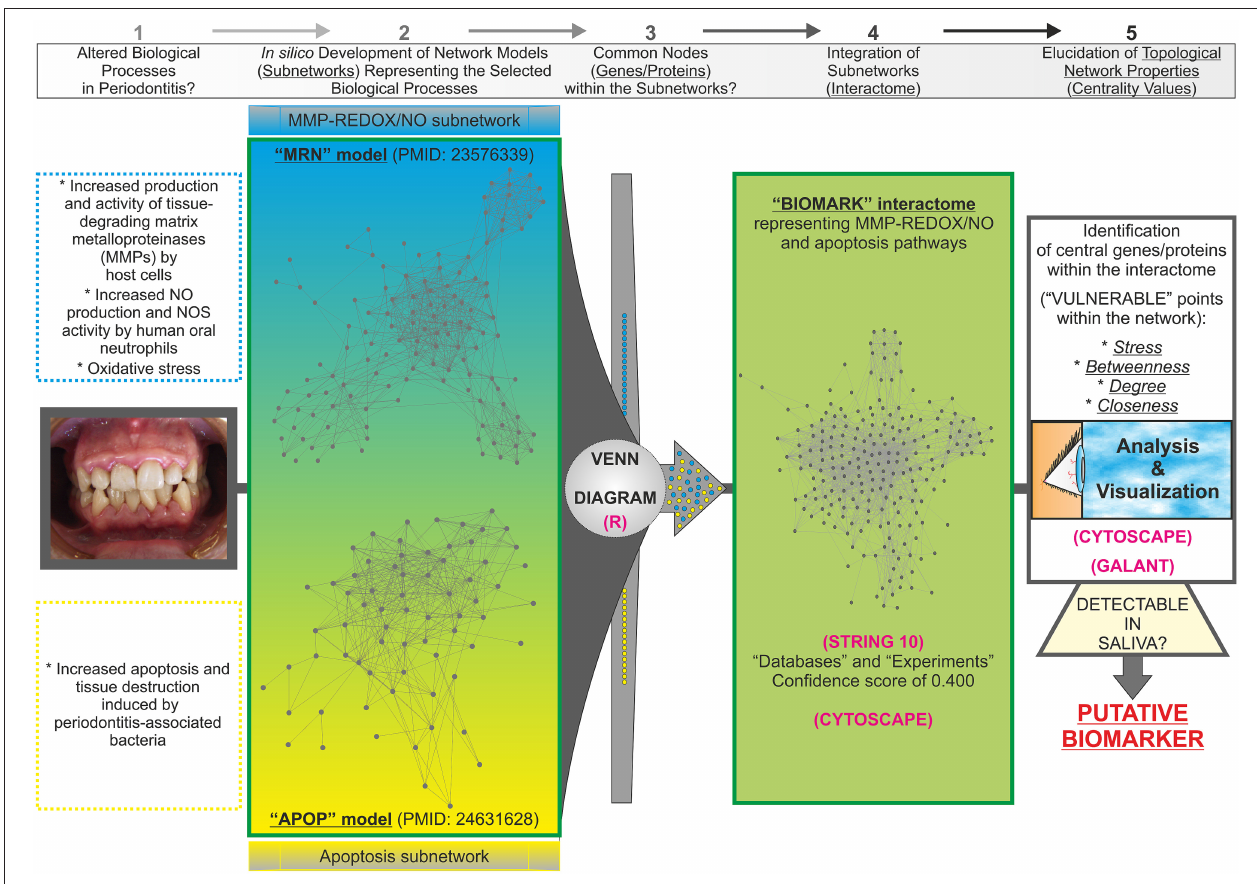
FIGURE 1 | Abstract workflow summarizing the criteria and tools used for the present study. The “MRN” and “APOP” in silico models, already available in the literature, were used as the starting material to develop the “BIOMARK” integrating MMP-REDOX/NO and apoptosis related-genes/proteins into one single network of interactions. The Venn diagram, performed by using the software system R, revealed the existence of common nodes (genes/proteins). Thereafter, the interactome was developed for integrating these subnetworks into one single gene/protein interaction network model (“BIOMARK”) by using the STRING 10 and Cytoscape tools. Further elucidation of the topological network properties reveals “vulnerable” points within the in silico model representing candidate diagnostic biomarkers and also potential molecular targets for therapeutics. With GALANT, a Cytoscape plugin, we project numerical data from the topological network properties (centrality measurements) onto “BIOMARK” interactome to create a smoothed data map resembling the network layout. Central members of “BIOMARK,” easily detectable in saliva, represent optimal candidates to be tested as periodontitis